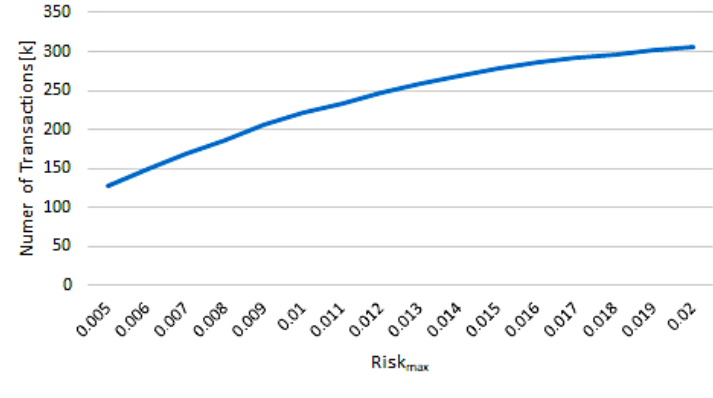
Figure 6. Number of selected transactions.